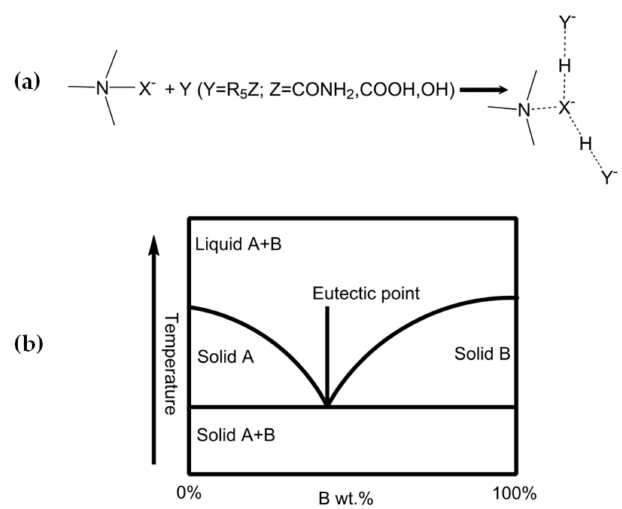
Figure 1. ( a ) Illustration of Type III deep eutectic solvent with hydrogen bond formed; ( b ) principle behind Type III deep eutectic